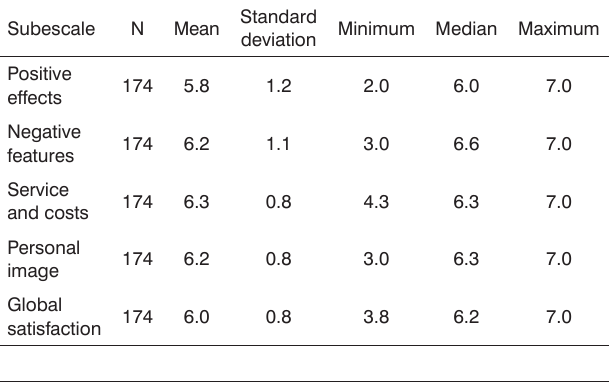
Table 4. Descriptive statistics for global satisfaction and subscales of SADL™